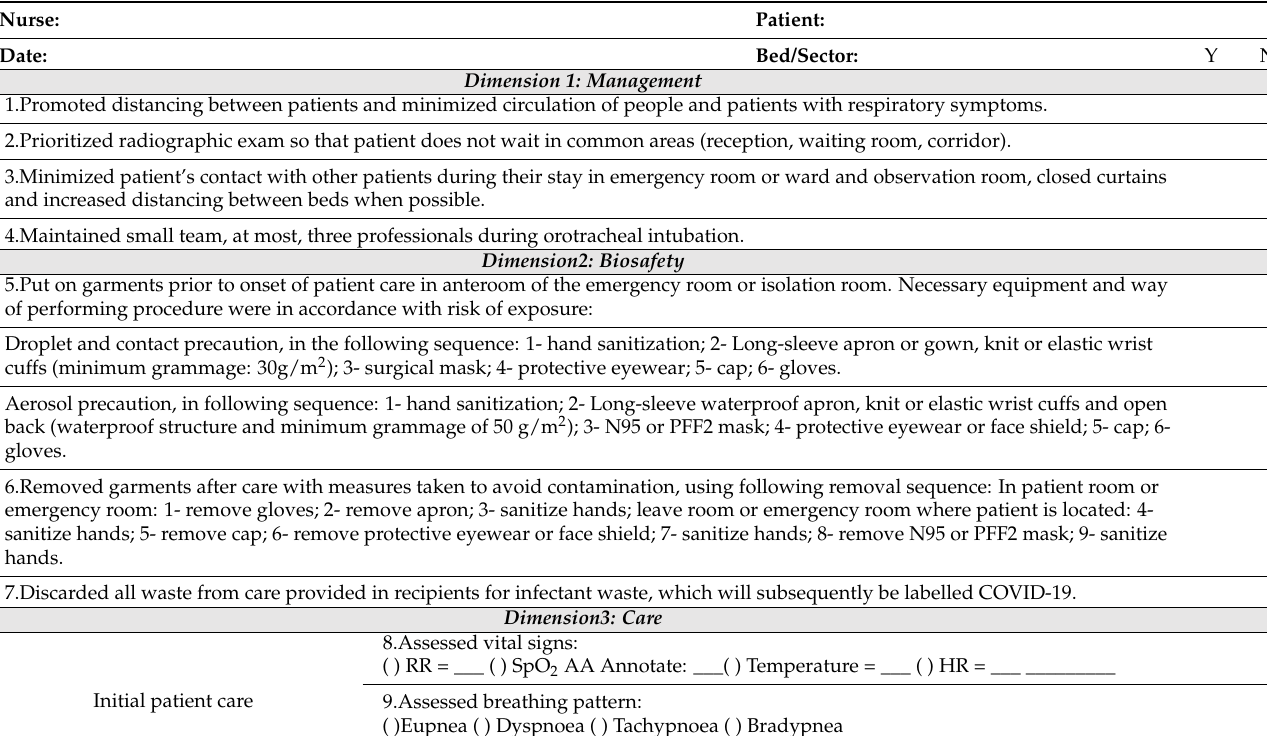
Table 4. Checklist for nursing care management of patients with suspicion or confirmation of infection by COVID-19 at 24-h